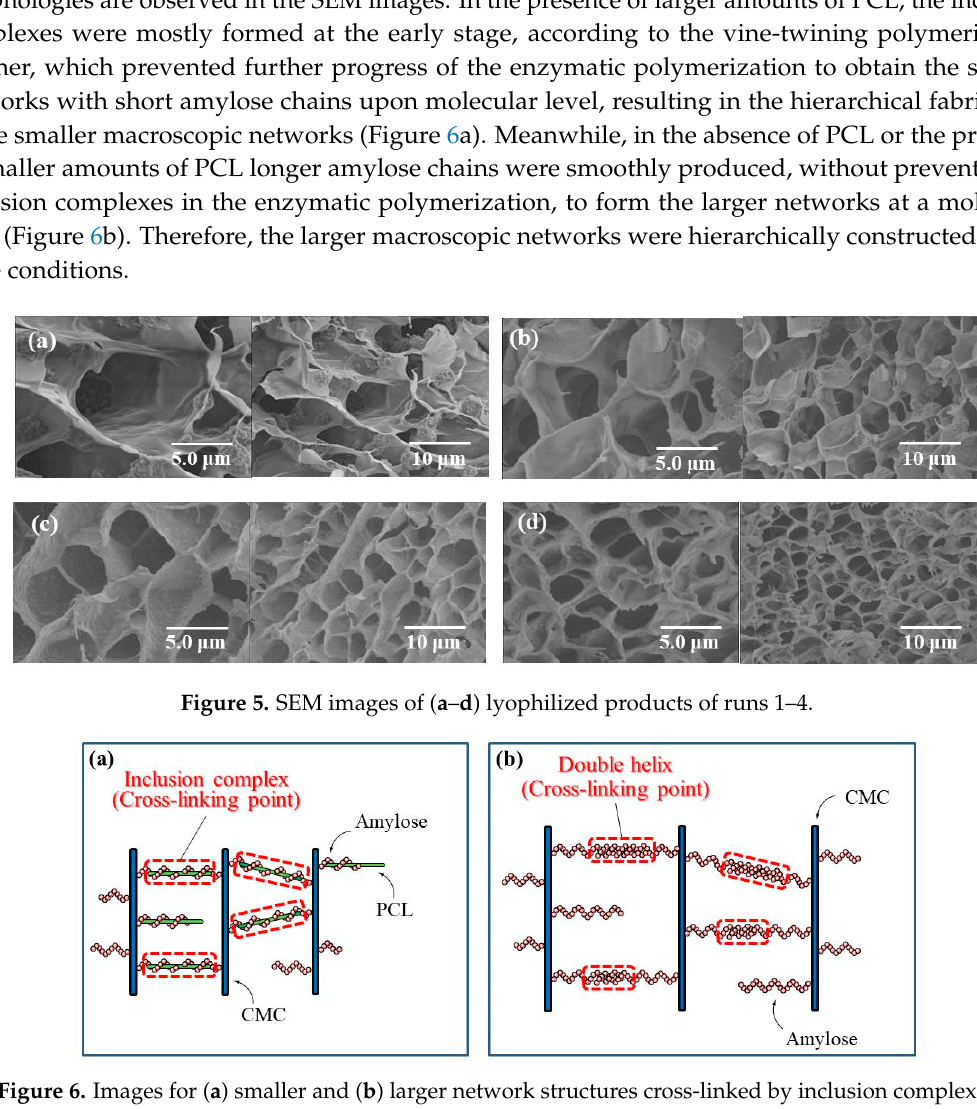
Figure 4. Evaluation of storage modulus G’ (circles) and loss modulus G” (triangles) as a function of frequency for products before lyophilization of run 2 with reaction times of ( a – d ) 0.5, 1, 3, and 5.